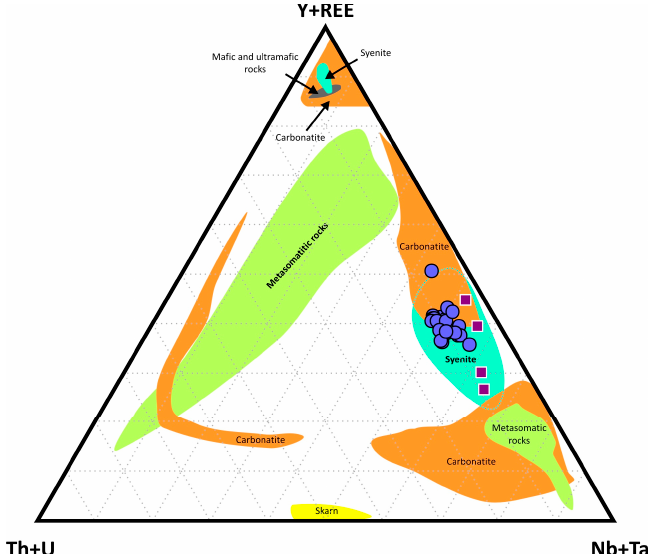
Figure 13. REE–(Th + U)–(Nb + Ta) diagram [28] with projection points of zirconolites from Hajná č ka (blue circles) and compositional fields for zirconolites from metasomatic rocks, skarns, syenites, mafic and ultramafic rocks, and carbonatites compiled from literature. Violet squares are projection points of laachite, stefanweissite, and nöggerathite from an alkaline syenite-carbonatite intrusive complex subjacent to the Laacher See volcano, Eifel volcanic region, Germany [33–35].